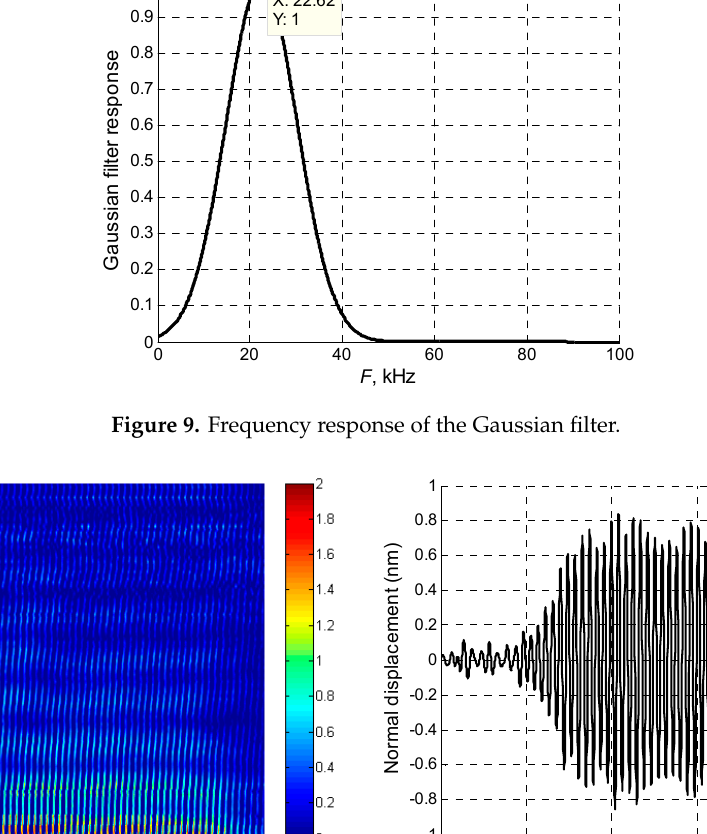
Figure 10. ( a ) B-scan recorded by laser interferometer before 2D filtering. ( b ) A-scan signal taken from B-scan before 2D filtering at a distance of 37.5 mm.